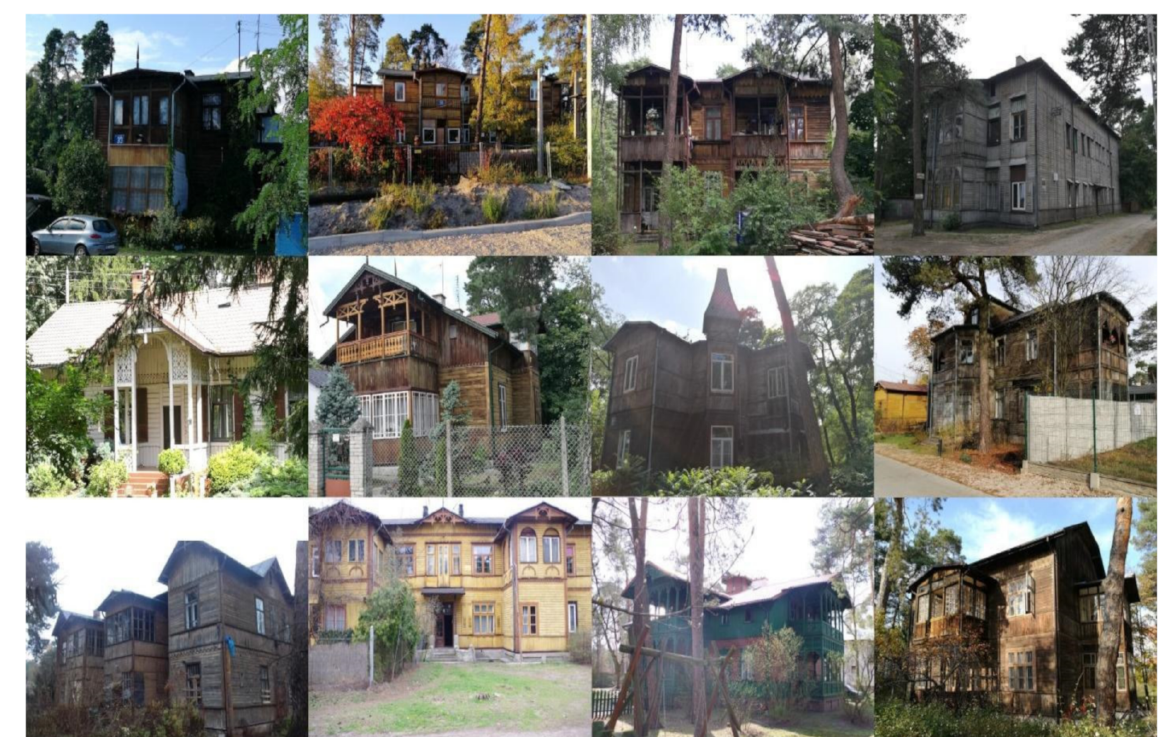
Figure 8. The examples of ‘Otwock Line’ buildings; photo: M. G ó rski.